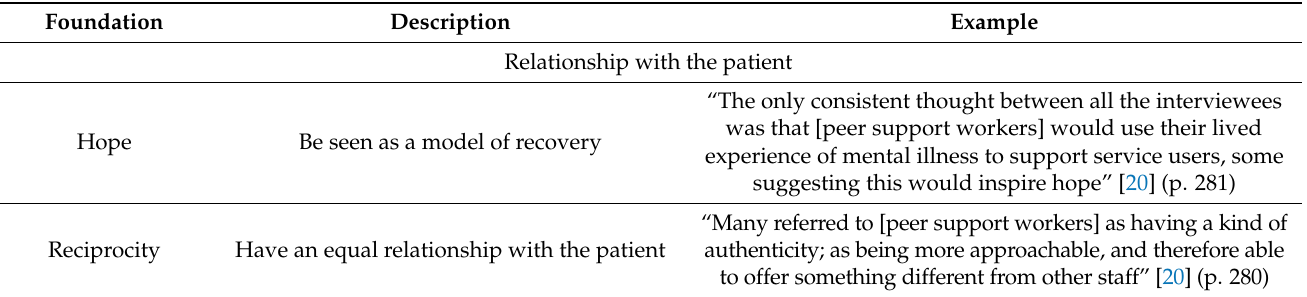
Table 3. Ethical foundations of the role of accompanying patients based on